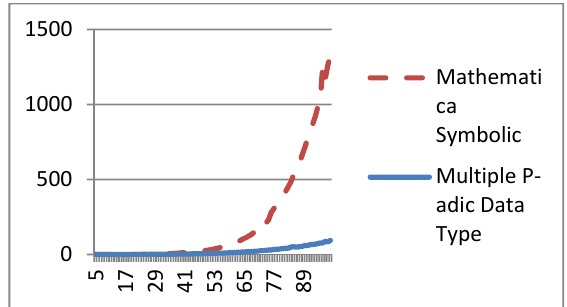
Figure 4. Vertical axis: calculation time (seconds) Horizontal axis: matrix